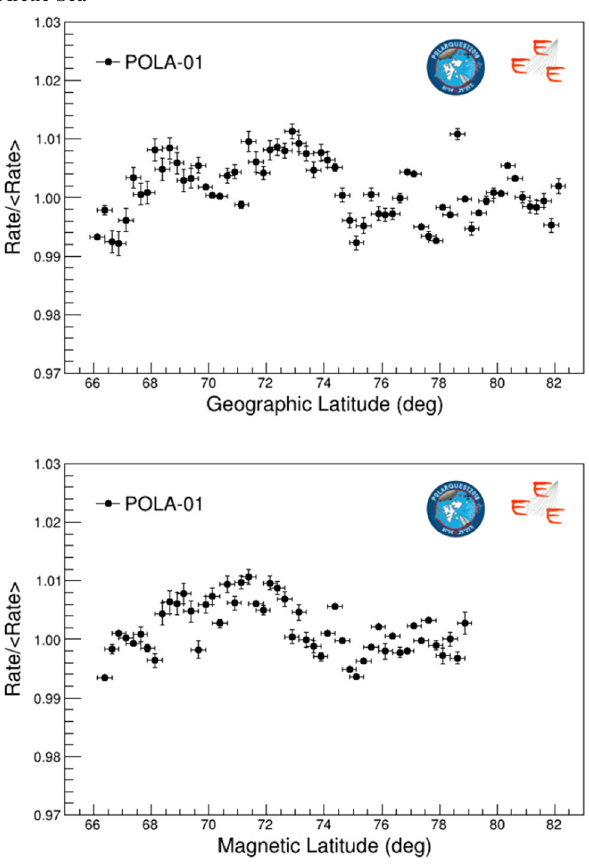
Fig. 27 Cosmic particle rates measured by the POLA detectors as a function of time since July 22, 2018. The green line shows the results of the best fit with a linear function of the time. Note that the scale used for POLA-03 is smaller with respect to the others, to make visible the observed